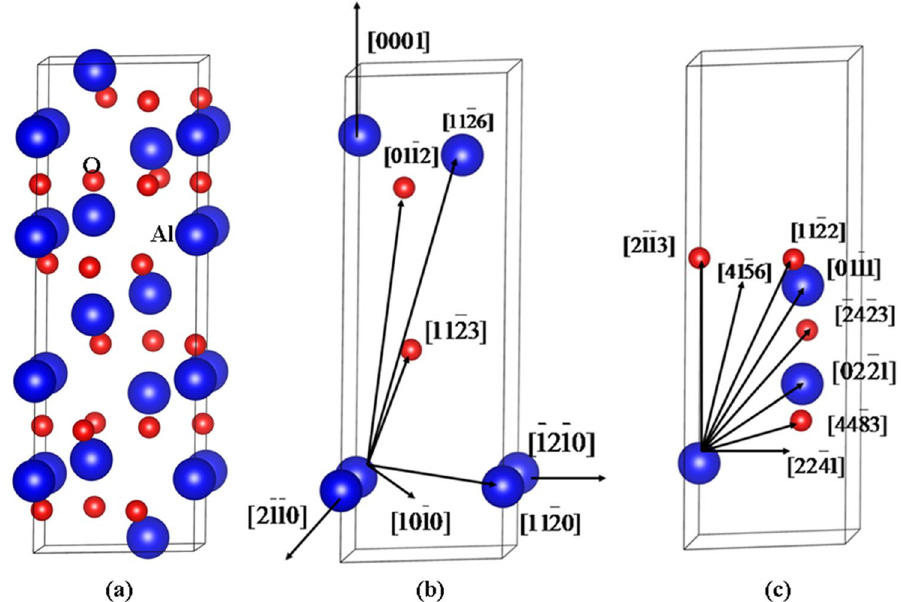
Figure 8. Illustration of schematic view of ( a ) α -Al 2 O 3 structure; ( b , c ) incident directions in α -Al 2 O 3